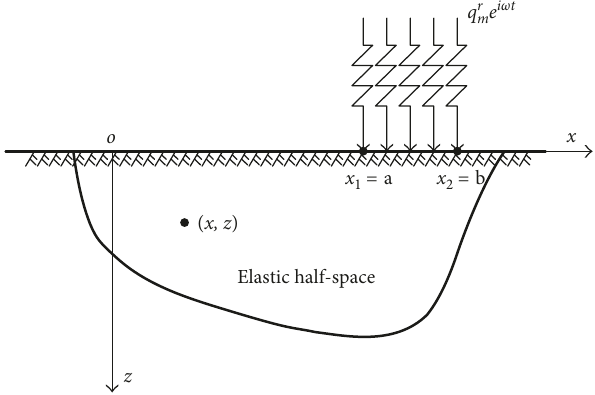
Figure 4: The half-space acted by a vertical harmonic uniform